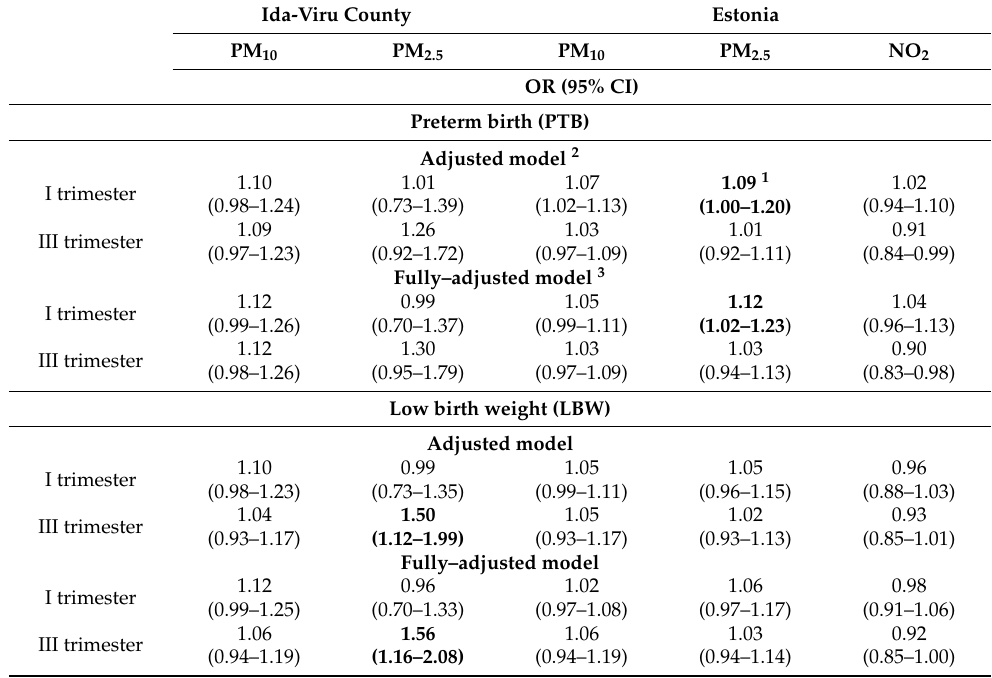
Table 2. Associations between adverse birth outcomes and exposure to air pollutants (per 10 µ g/m 3 ) during the first and third trimesters in Estonia and Ida-Viru